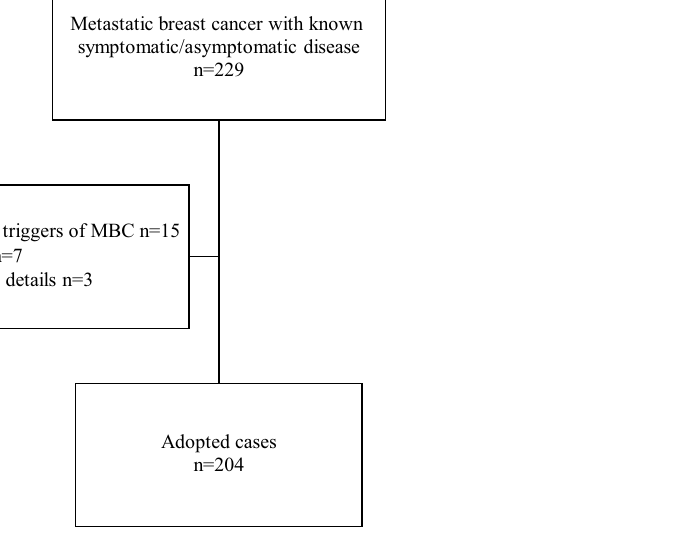
Figure 1. Flowchart showing the patient selection